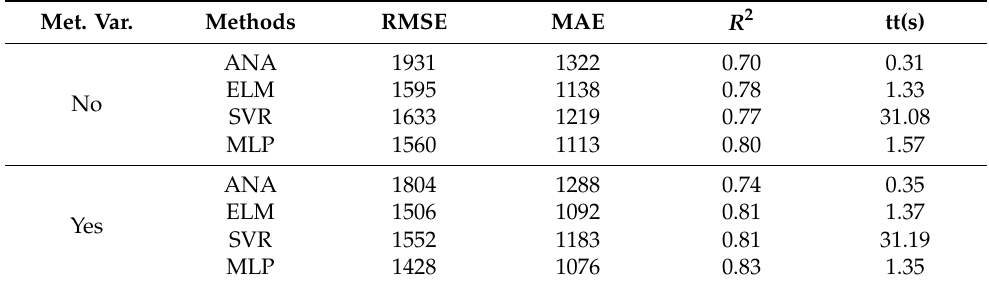
Table 7. Performance of the evaluated ML methods in the bike sharing demand prediction problem in Madrid. Met. Var. Met.